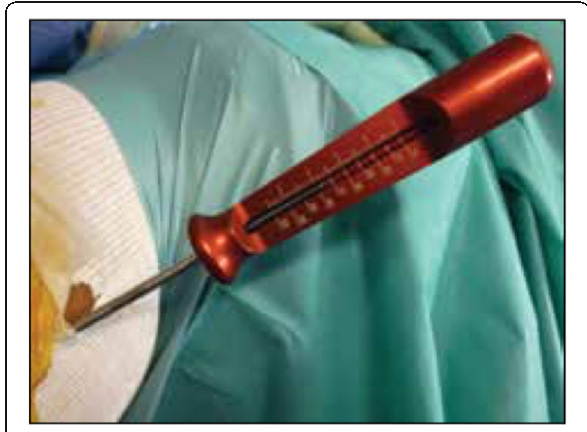
Fig. 2 Intraoperative measurement of tunnel